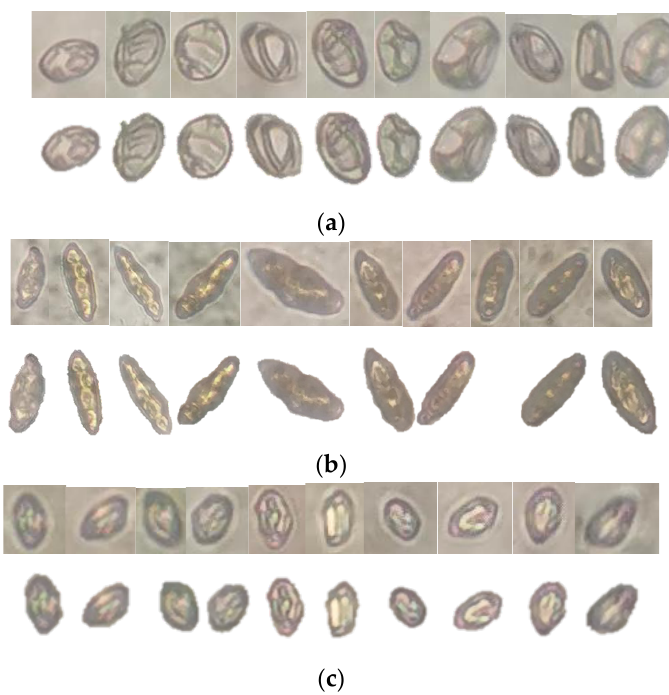
Figure 4. Some spore images and their preprocessed images: ( a ) B. cinerea spores ; ( b ) P. xanthii spores; ( c ) P. cubensis spores.